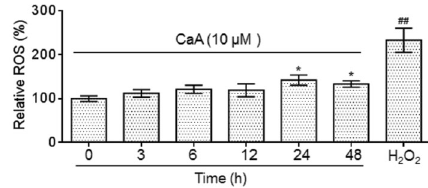
Figure 3. Caffeic acid (CaA) generated relatively lower levels of reactive oxygen species (ROS) in L-02 cells compared to cells treated only with H 2 O 2 . L-02 cells were treated with 10 m M CaA for 0, 3, 6,12, 24, or48 h. Cellsexposedto40 m MH 2 O 2 for24 hserved as positive controls. ROS levels were measured with the DCF fluorescence method. *P , 0.05 compared to medium control cells; ## P , 0.01 compared to medium control cells and to CaA treatment at all times (one-way ANOVA followed by Dunnett’s t